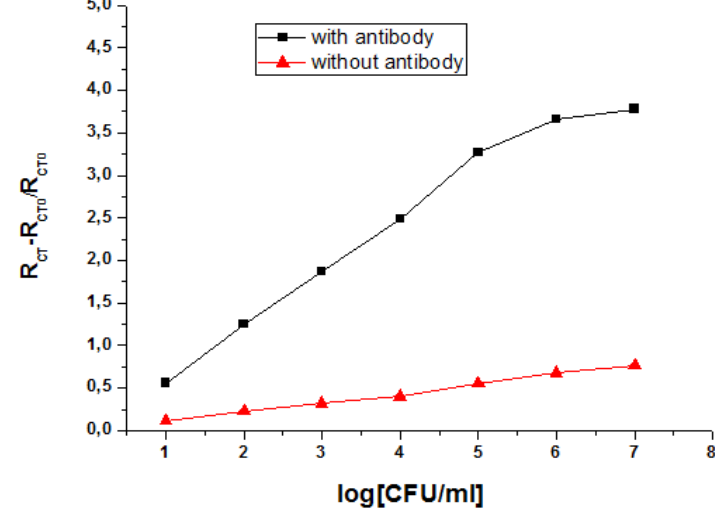
Figure 7. A comparative study of the response of the modified electrode (relative variation of R ) in the presence and absence of antibodies. CT